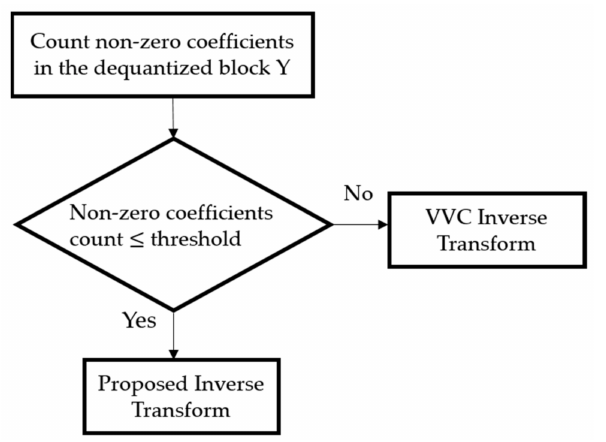
Figure 2. Flow chart of the proposed